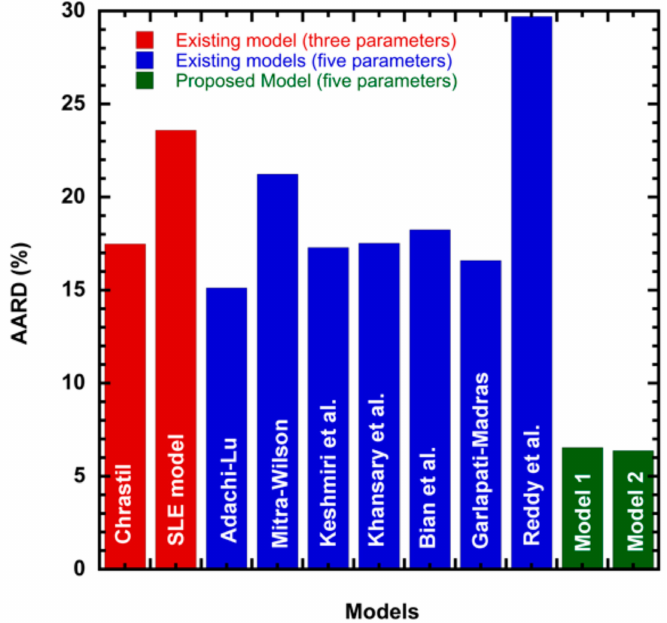
Figure 7. Global mean AARD% of literature models and the proposed